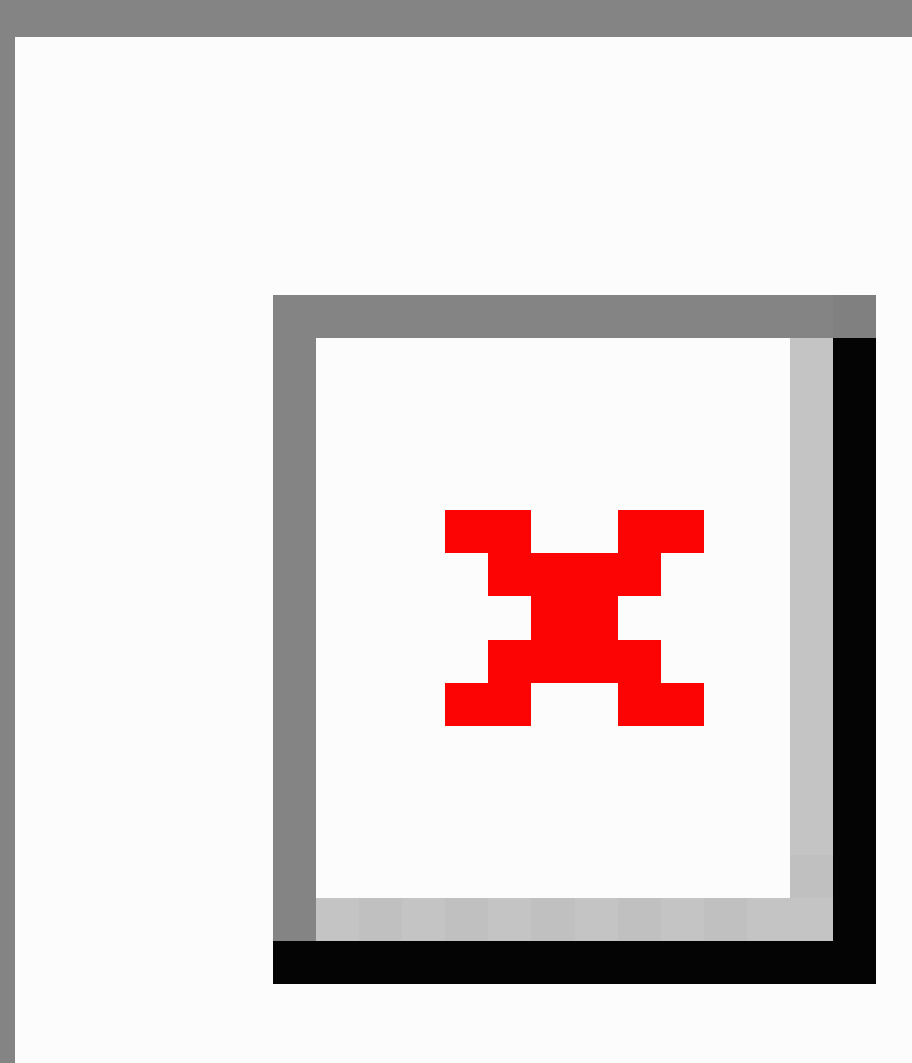
Figure 1. Nonresponse follow-up recruitment